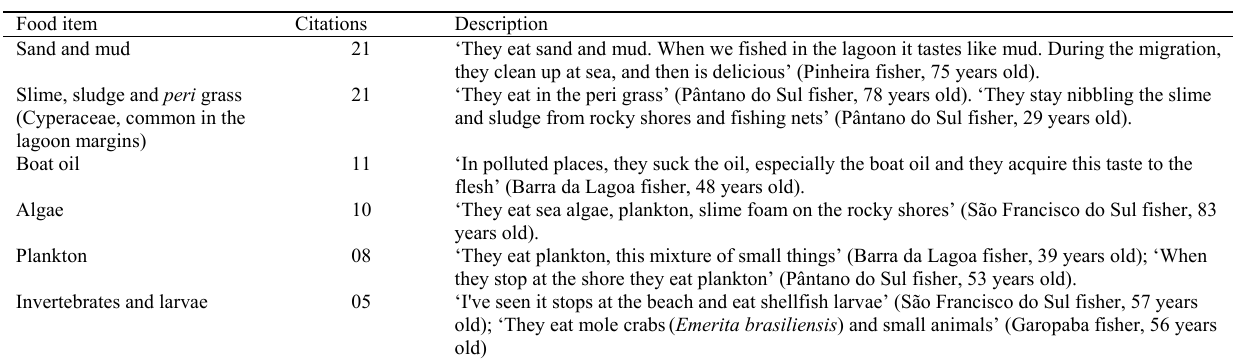
Table 6. Food items in mullet diet, according to 45 interviewed fishers in Santa Catarina State, Brazil (six of our informants did not knew about this particular ecological